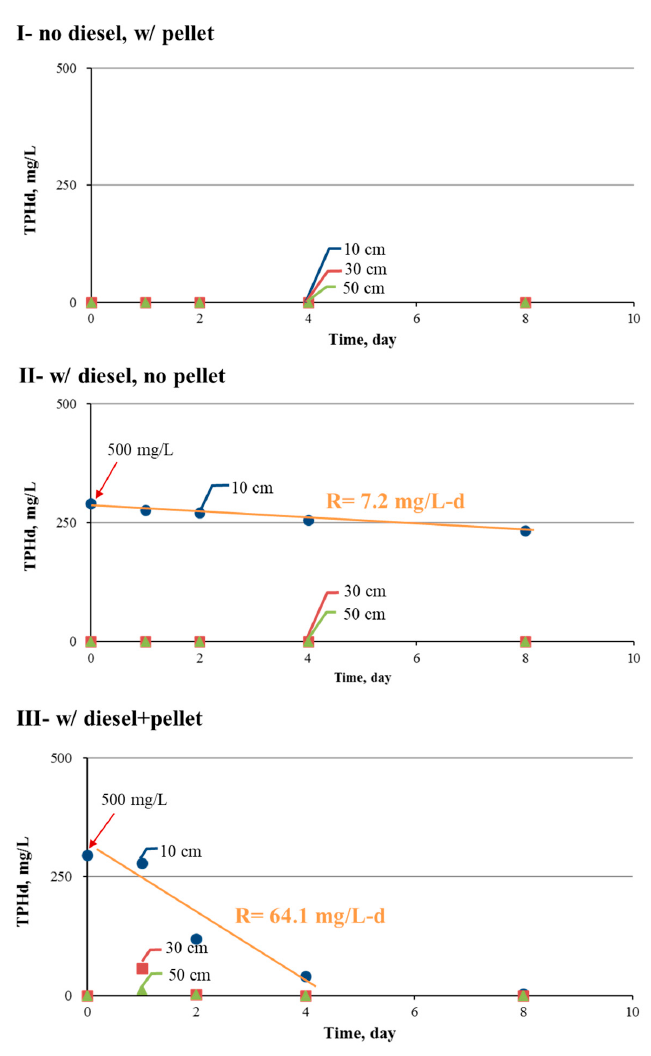
Figure 6. TPHd removal from Day 0 to 8 in the mimicked groundwater system.